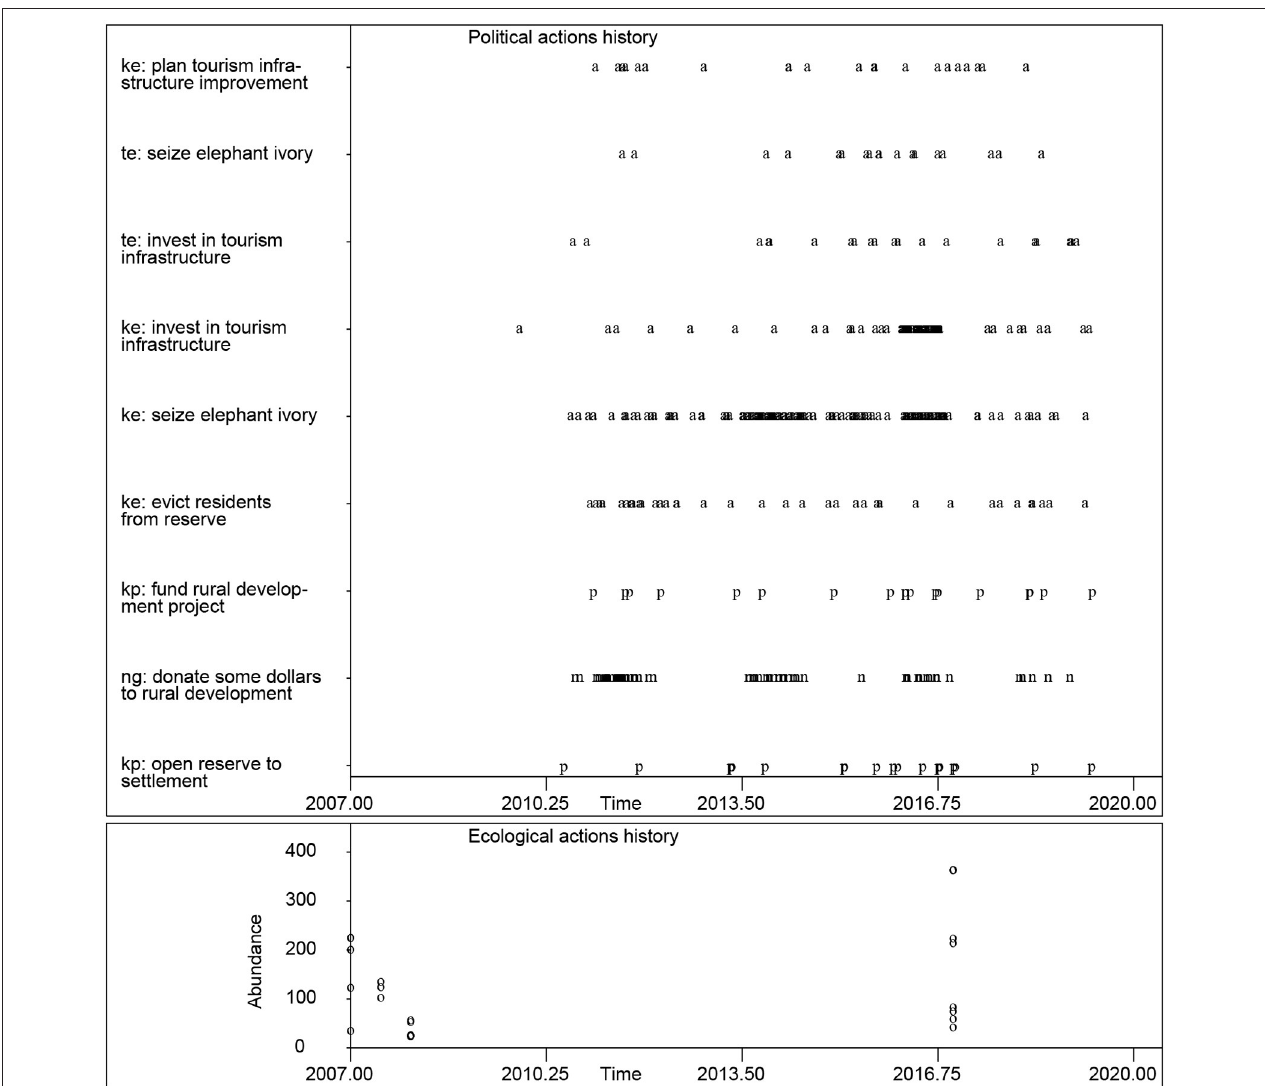
FIGURE 4 | Observed actions history from East African online news stories for the period from January 2007 to June 2019. The presidential office of Kenya, Tanzania, and Uganda are designated by kp , tp , and up , respectively. Similarly, the environmental/wildlife protection agencies are designated with ke , te , and ue ; non-pastoralist, rural residents with kr , tr , and ur ; and pastoralists with ka , ta , and ua . The group of conservation NGOs who have operations in at least one of these countries is represented by ng . The plotting symbol p indicates an action taken by a presidential office, a an action taken by an EPA, r an action taken by rural residents, s an action taken by pastoralists, d an action taken by a developer, s an action taken by pastoralists, t an action taken by tourists, l an action taken by a legislature, j an action taken by a judge, and n an action taken by an NGO. Only frequent out-combinations are shown. The bottom plot is observed cheetah